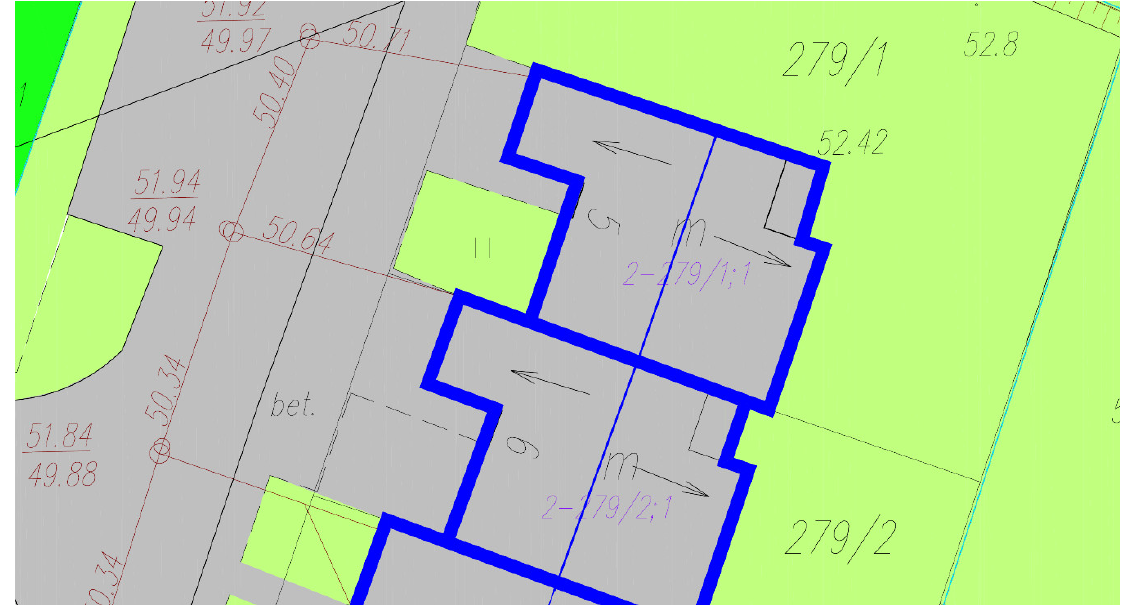
Figure 9. Terraced houses with pitched roofs.